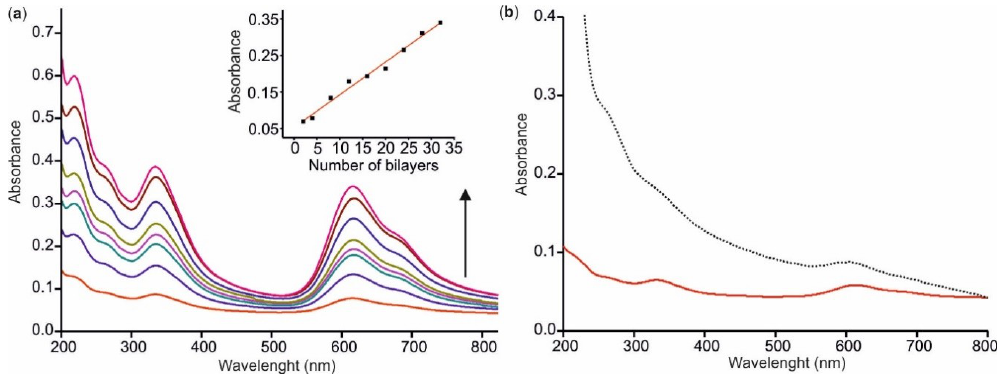
Figure 2. ( a ) UV–vis spectra of [CHI+IL/CuPc S ] n films with increasing number of layers ( n = 2, 4, 8, 12, 16, 20, 24, 28, 32). The inset shows the correlation between absorbance at 617 nm and the number of layers; ( b ) comparison of the spectra of [CHI+IL/CuPc S ] 2 (solid red line) and of [CHI+IL/CuPc S ] 2 -GAO (dotted black line).